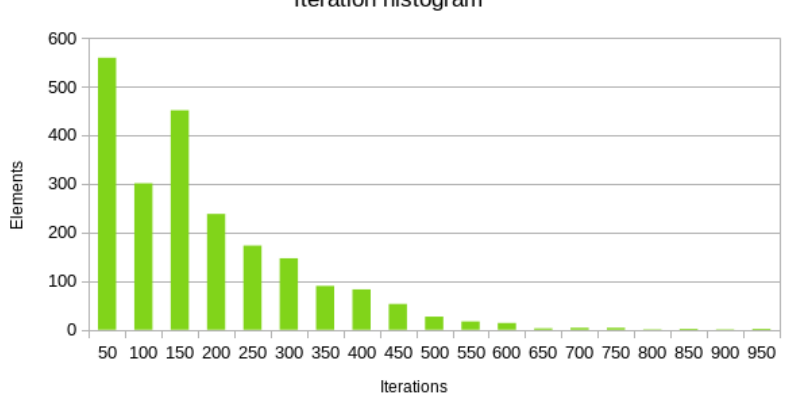
Figure 8. Skeleton inverse kinematics histogram.